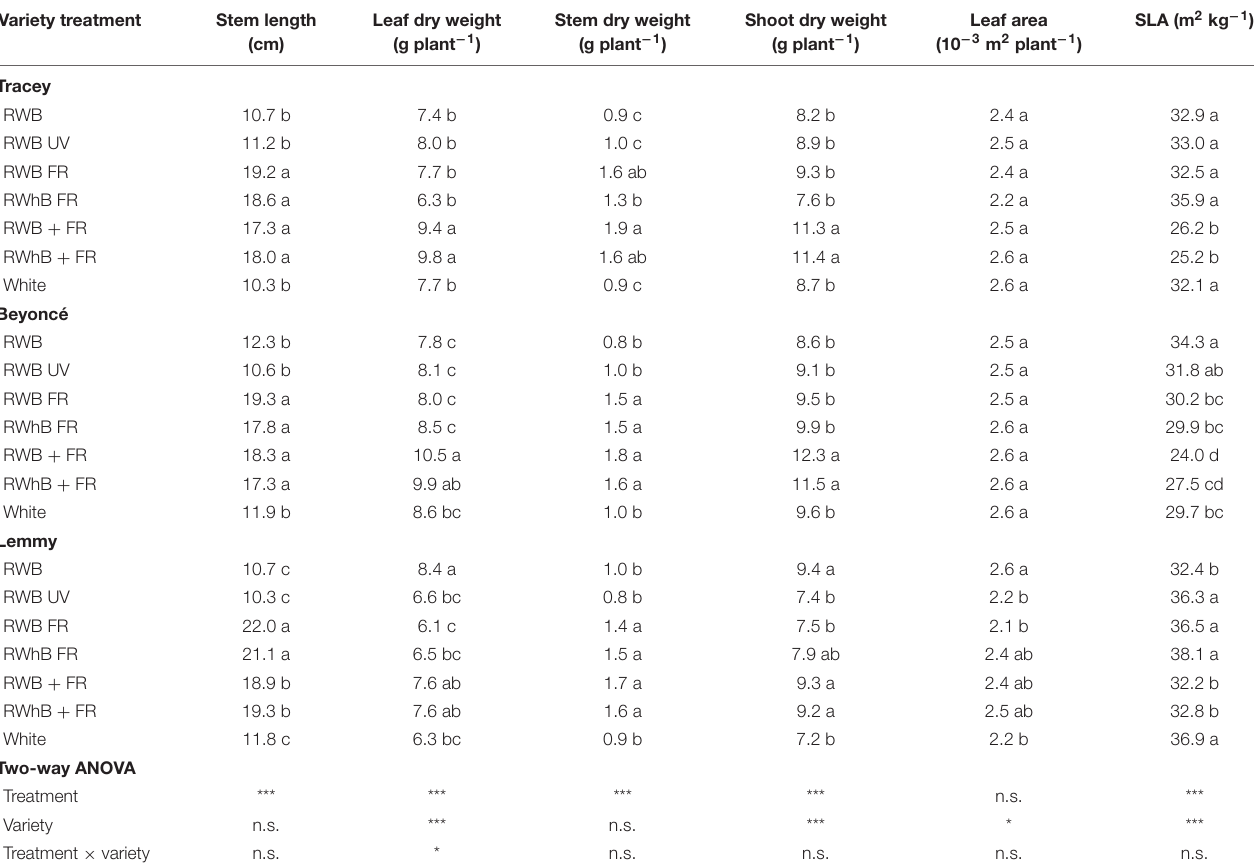
TABLE 2 | Effects of spectral composition on vegetative eggplant traits. Variety